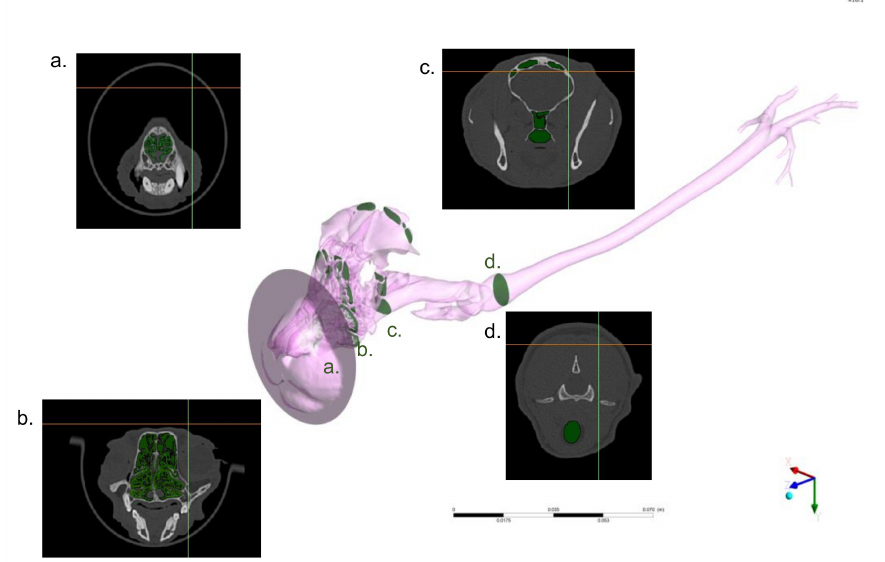
Figure 2. Computerized Tomography (CT)-based three-dimensional model generation. Non intu- bated cat is shown as an example: the four green markers correspond to transverse sections on CT from the rostral nasal cavity and muzzle ( a ), through the turbines meatus ( b ) and nasopharyngeal area ( c ) to the laryngeal entrance to the trachea ( d ). CT images are extracted from images and used with the other sections (not shown) for building the entire model (represented in purple).